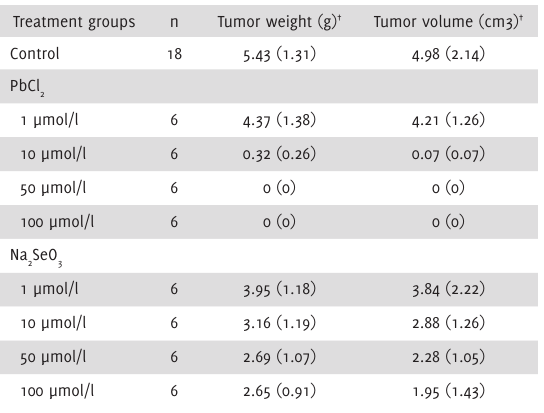
Table 2. Tumor Weight and Volume after 12 Days of Treatment.